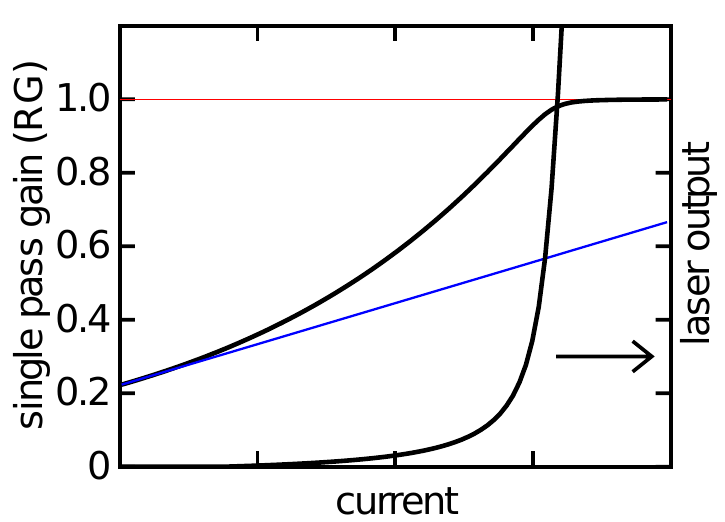
Figure 2. Simulated RG product and output power for a GaAs TJS laser. Note the exponential rise and saturation near threshold, consistent with the expression for the single pass gain, Equation (8), and the measured data of Figure